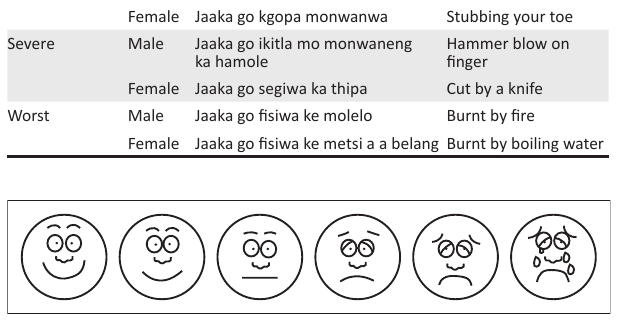
FIGURE 1-A1: The Wong–Baker FACES Scale.